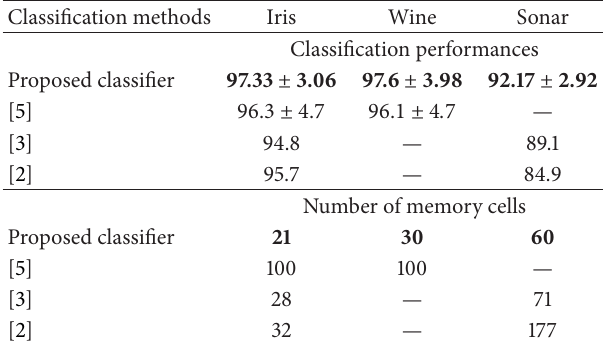
Table 1: Comparative results for the proposed